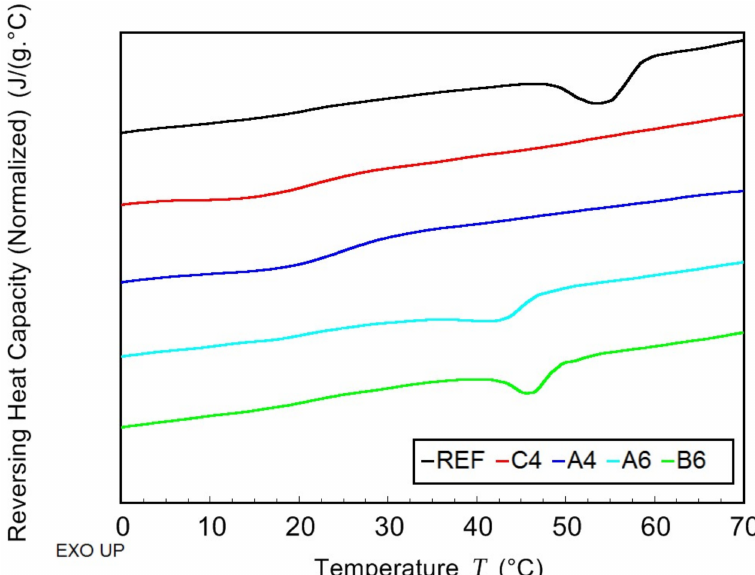
Figure 5. DSC—second heating scan of non-plasticized reference sample (REF) and PHB/PLA/Plasticizer (where the plasticizers are: C-4, A-4, B-6, and A-6).